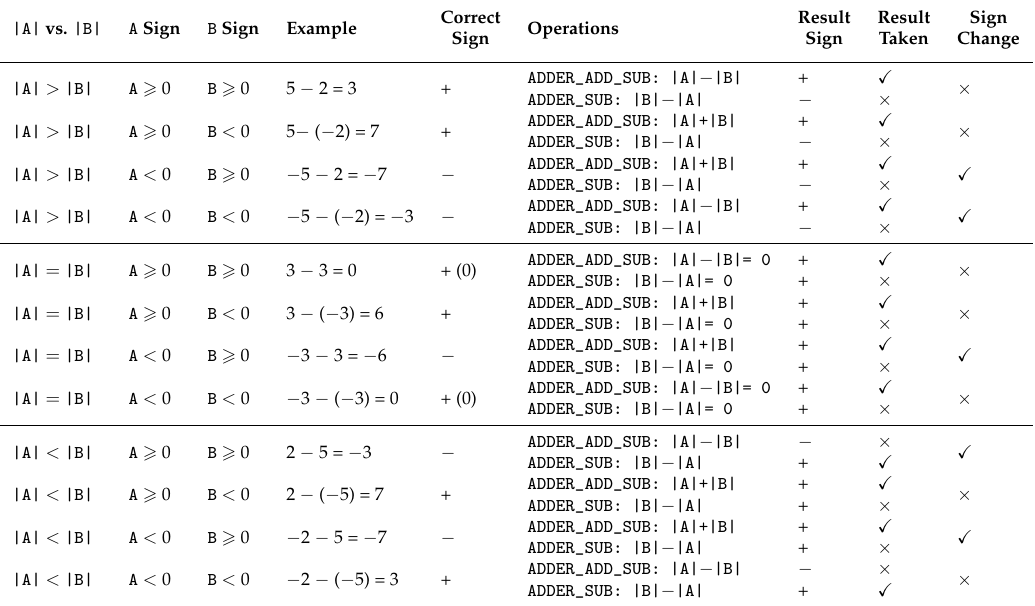
Table 3. Truth table allowing us to adjust sign and take corect register as result of subtraction [24].